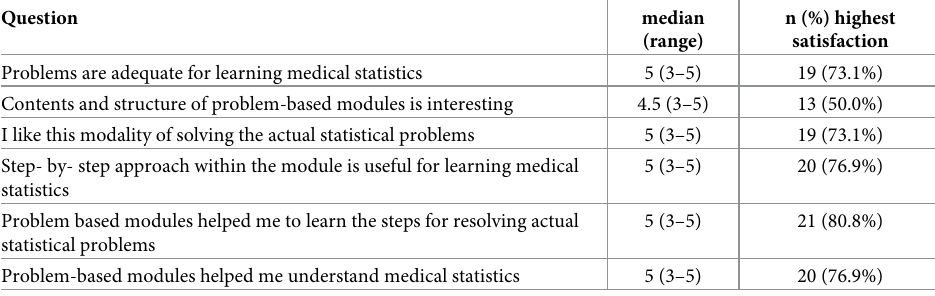
Fig 3. The relationship between the total medical statistics score and factors associated with it in multivariate linear regression model. hPBL –hybrid Problem Based Learning, BL –Blended Learning. https://doi.org/10.1371/journal.pone.0263015.g003 Table 6. Students’ attitudes towards the implemented problem solving